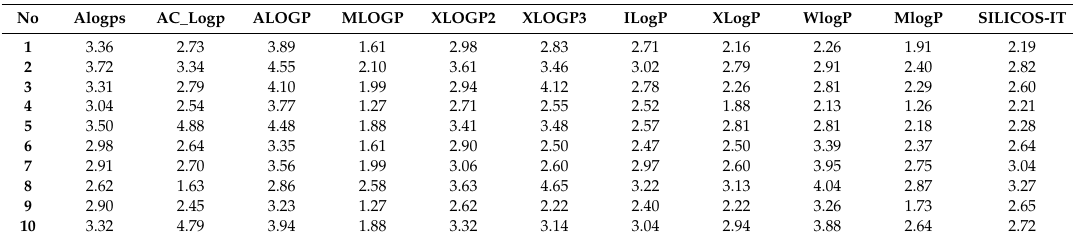
Table 1. The calculated log P calcd values for 1,2,3-triazole-dipyridothiazine hybrids ( 1–10 ) using the internet databases: VCCLAB [31] and SwissADME [32].